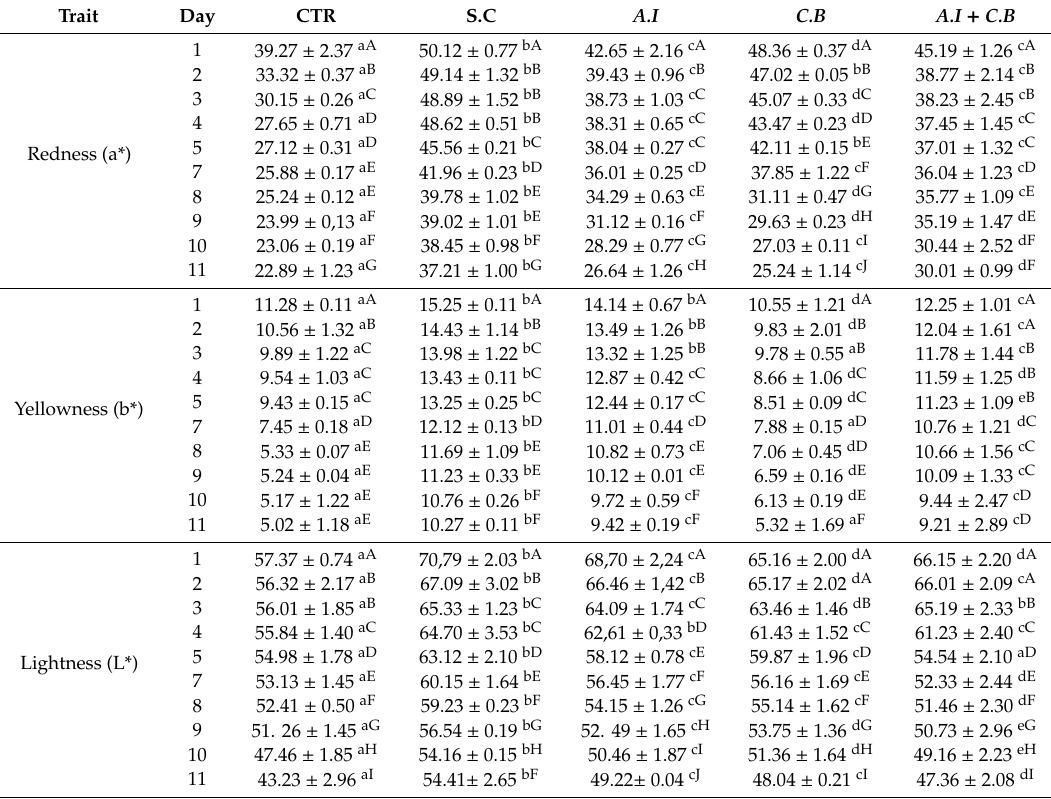
Table 3. Color changes (a*, b*, L*) in treated raw beef patties during refrigerated storage at 4 ± 1 ◦